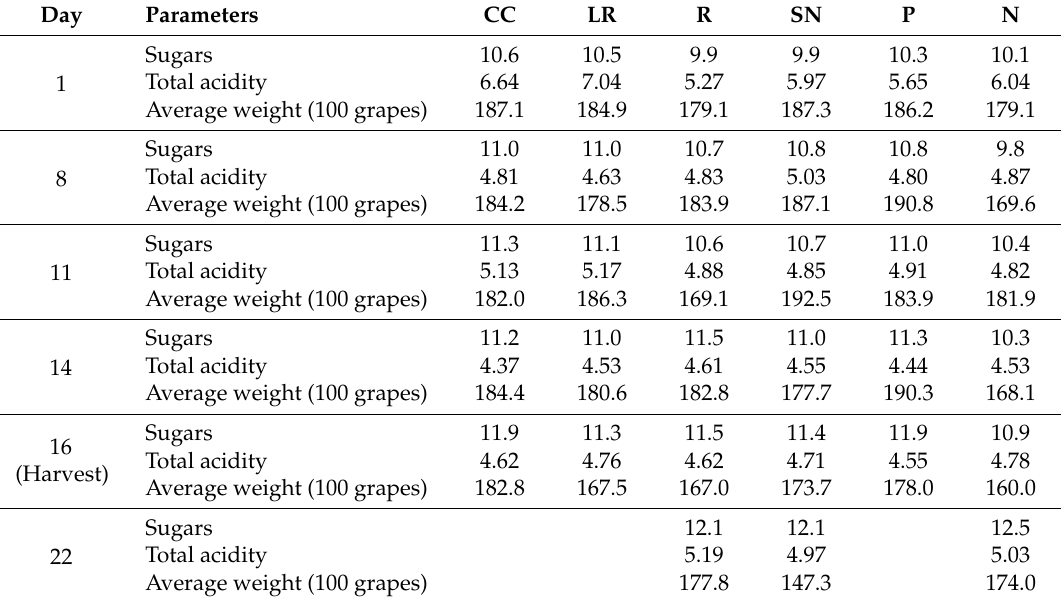
Table 1. Levels of sugars (Baum é degrees), total acidity (g/L tartaric acid equivalent), and average grape weight (g/100 grapes) during the ripening